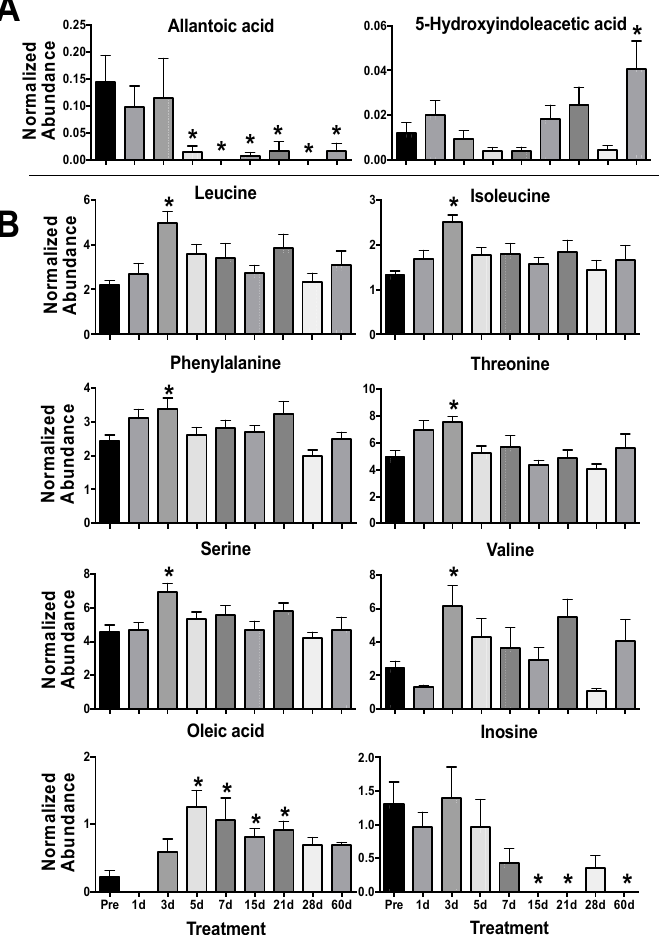
Figure 2. Urine ( A ) and serum ( B ) metabolites significantly perturbed after 4 γ Gy TBI in NHPs from 1–60 d. (* P < 0.05 determined by a Kruskal-Wallis test and post hoc Dunn’s multiple comparison test, mean ± SEM, pre-exposure samples [-8 and -3 d] were averaged for the control group). In serum, perturbed levels of several amino acids were evident at 3 d with significantly higher levels of leucine ( P = 0.002), isoleucine ( P = 0.011), phenylalanine ( P = 0.004), threonine ( P = 0.003),